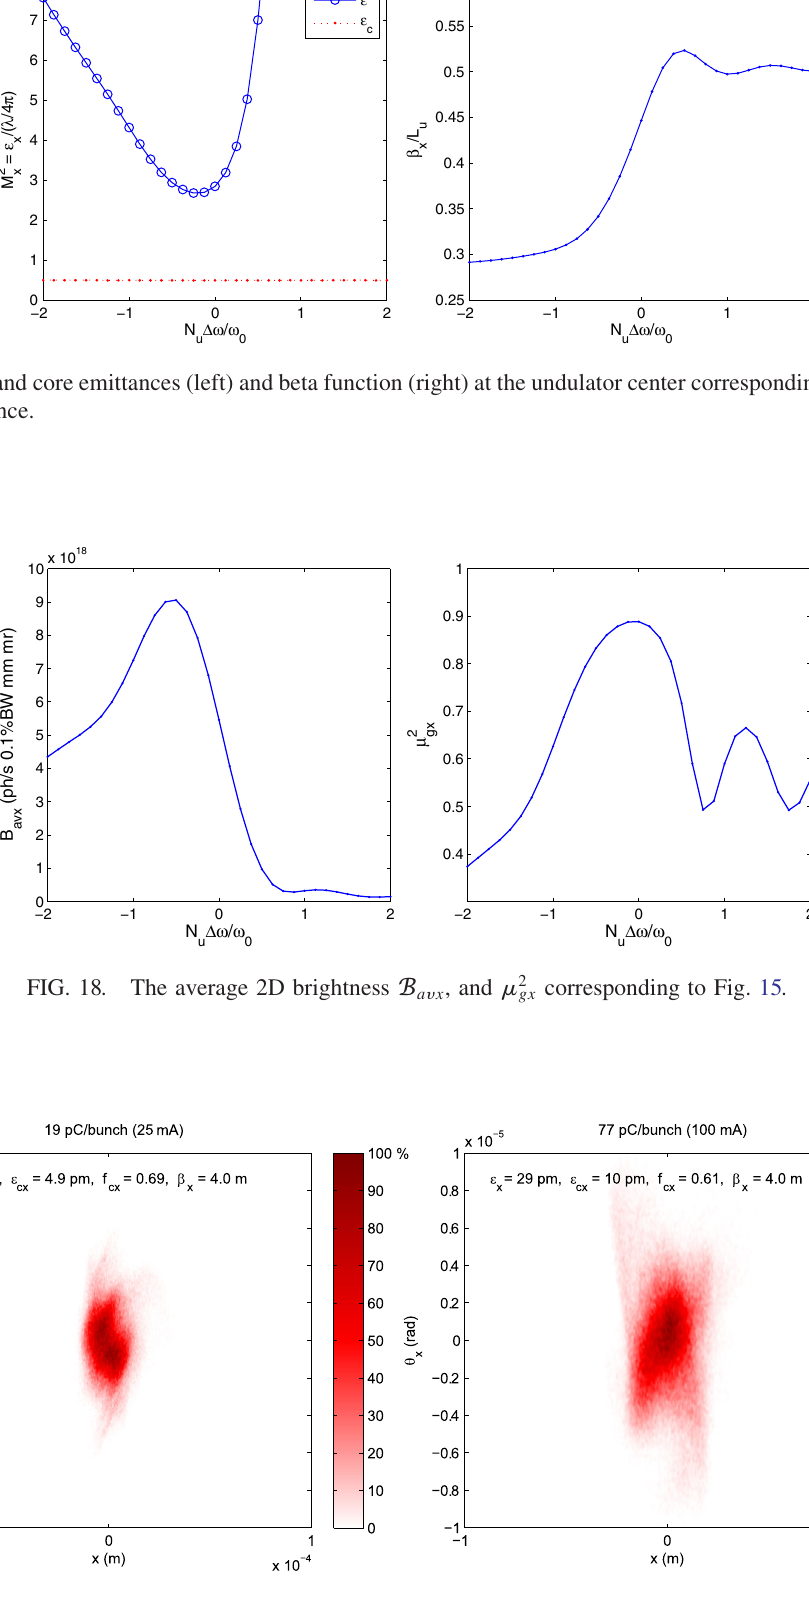
FIG. 19. Electron phase space at the center of 25 m long undulator corresponding to two different currents: 25 mA (left) and 100 mA